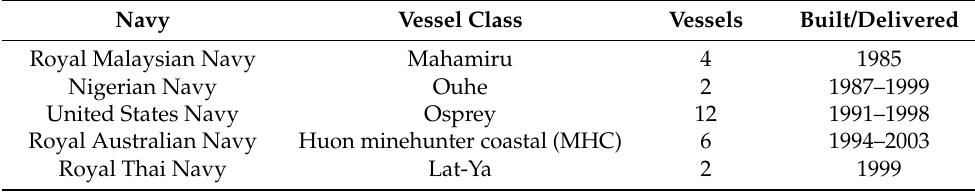
Table 1. Intermarine Mine-Counter Measures Vessels (MCMV) supplied to foreign